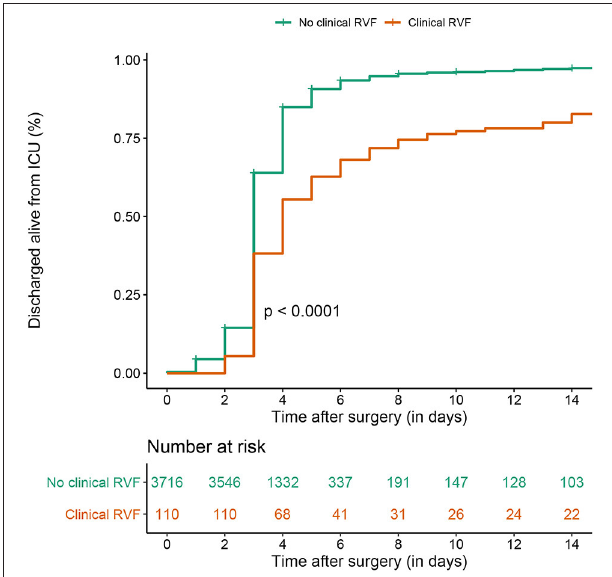
FIGURE 2 | Kaplan–Meier estimate of ICU discharge alive, censored at 14 days between clinical post-operative RVF and control patients in the overall surgery cohort.